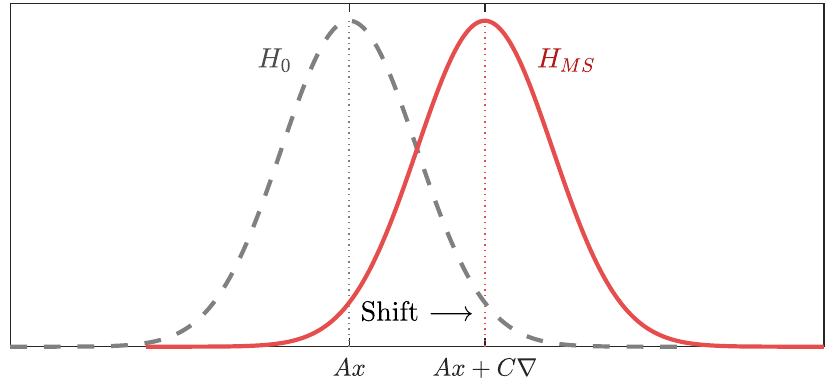
Figure 1. Schematic representation of the MS approach. The null model H 0 is depicted by a dashed grey line and the alternative model H MS is shown as a solid red line.